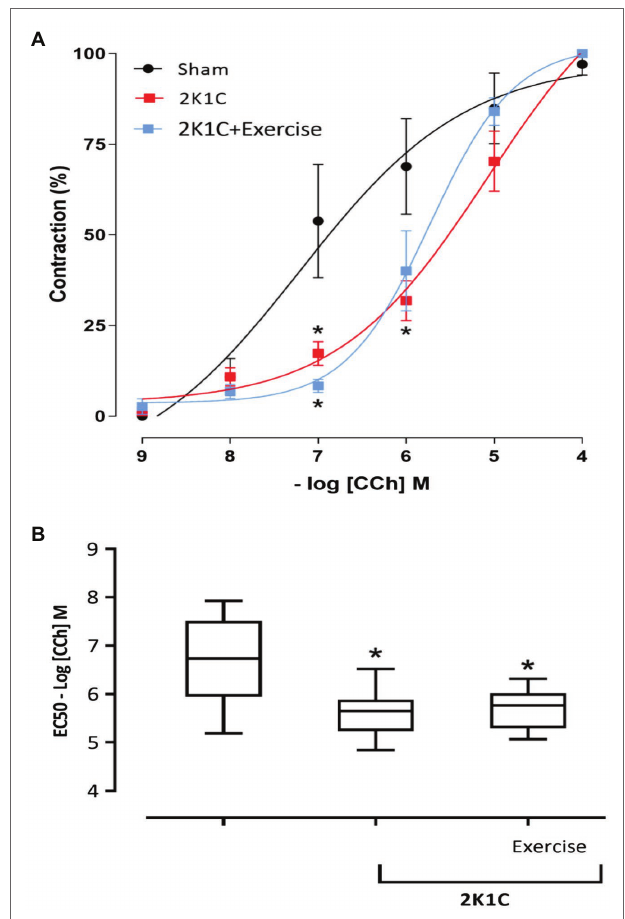
FIGURE 5 | Responsiveness to Carbachol (CCh) in duodenum. (A) Cumulative curve of the effect of Carbachol (CCh) responsiveness in strips isolated from the duodenum (%); (B) median EC50 values [(25% percentile) – (75% percentile)] in strips isolated from the duodenum. Experimental groups: Sham, 2K1C, and 2K1C + Exercise. Results are described in mean ± SEM; one-way or two-way ANOVA was used followed by Tukey’s test. Significance: p < 0.05: * vs.